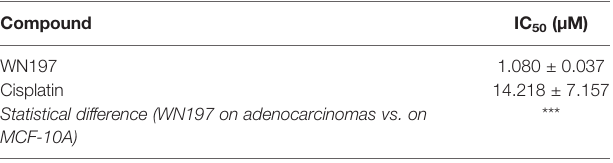
Data are expressed as the mean ± SD of three independent experiments. Statistics were based on Student ’ s t-test of the difference between WN197 IC 50 on adenocarcinomas and MCF-10A;